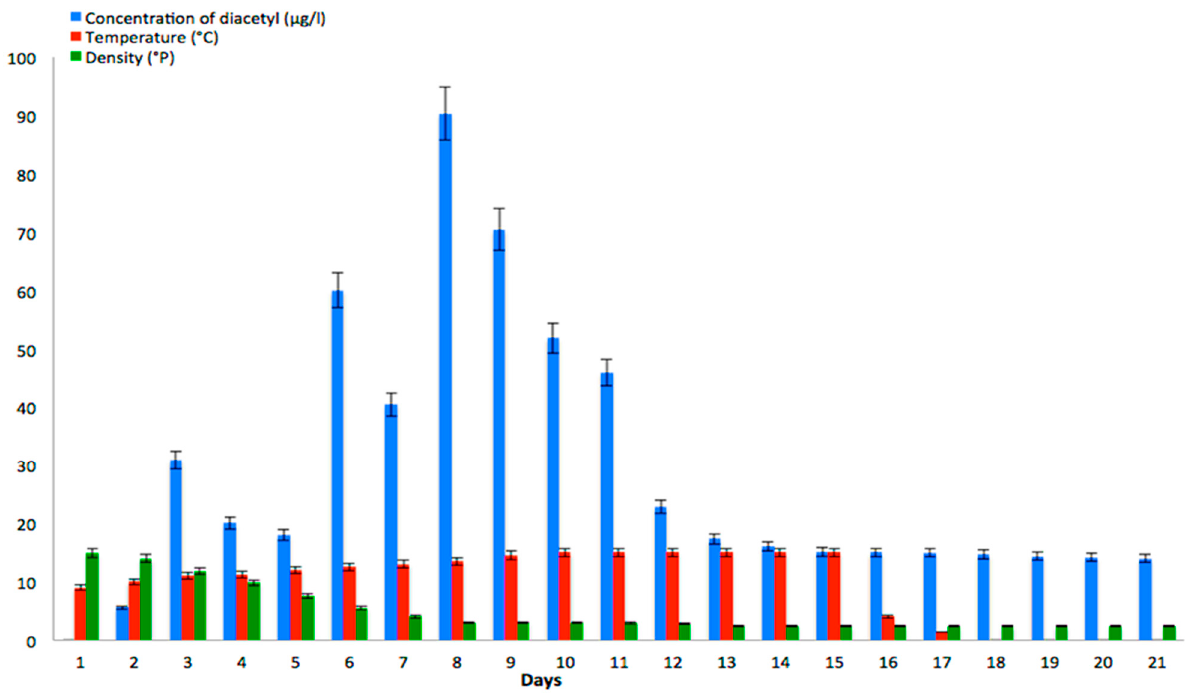
Figure 1. Monitoring of diacetyl concentration during classical fermentation.